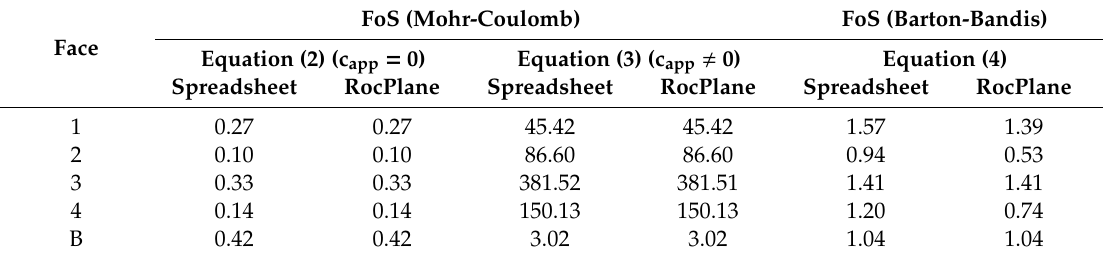
Table 6. Summary of results in terms of FoS with respect to planar sliding